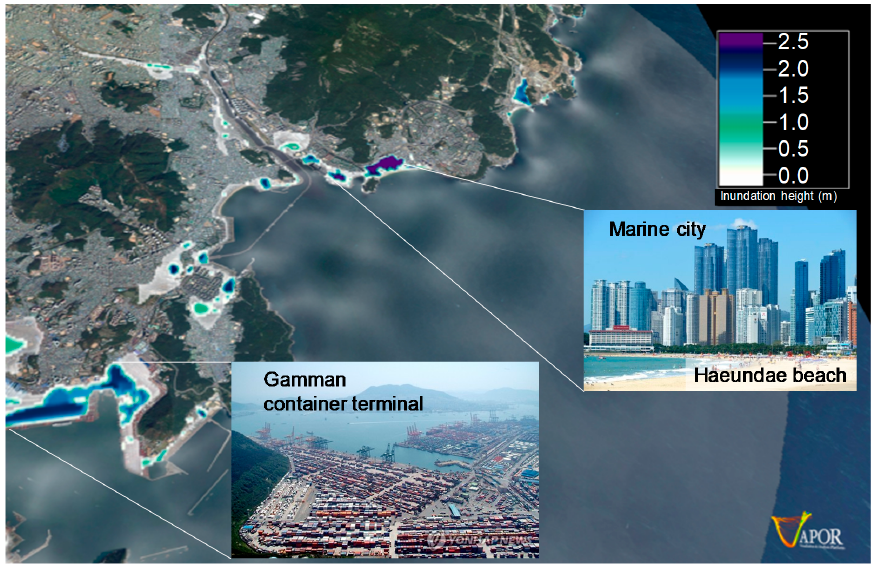
Figure 12. Visualization of coastal inundation results on the South coast near Busan city. with